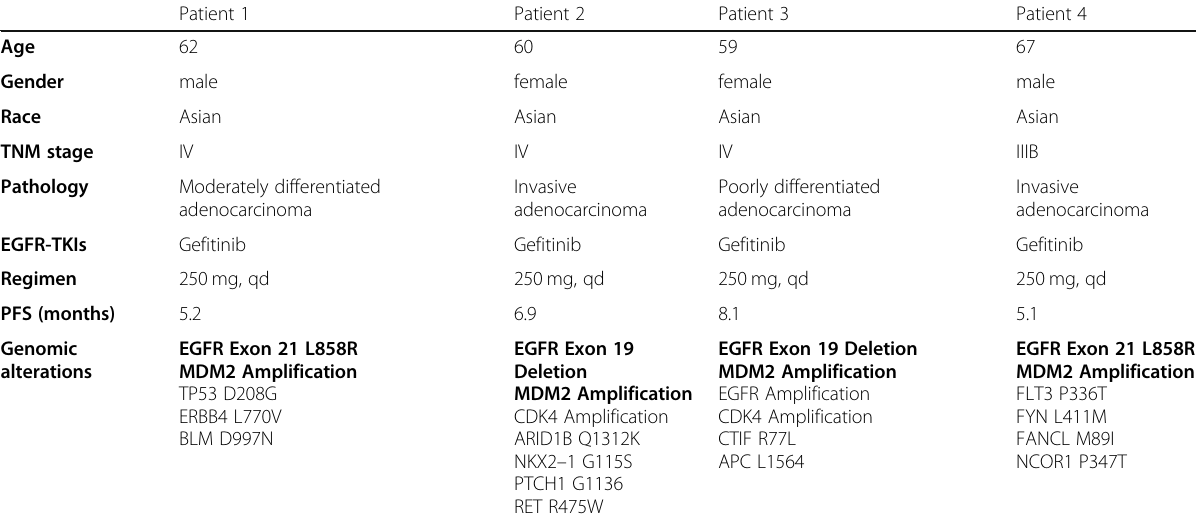
Table 1 Basic characteristics and NGS examination of four